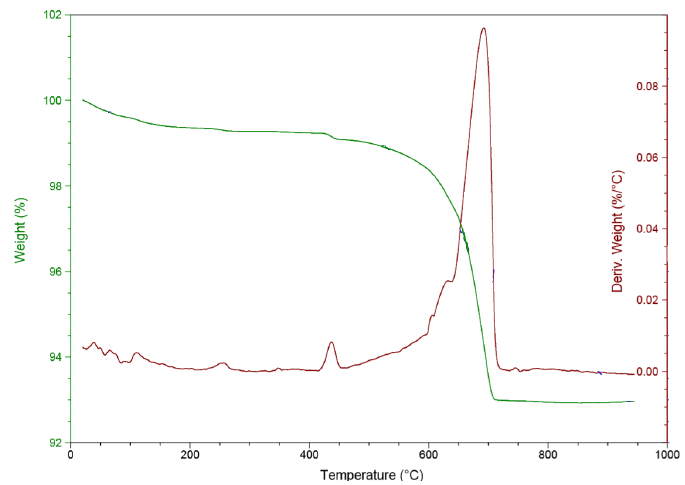
Figure 5. DTF curve of Portland cement CPII–Z–32